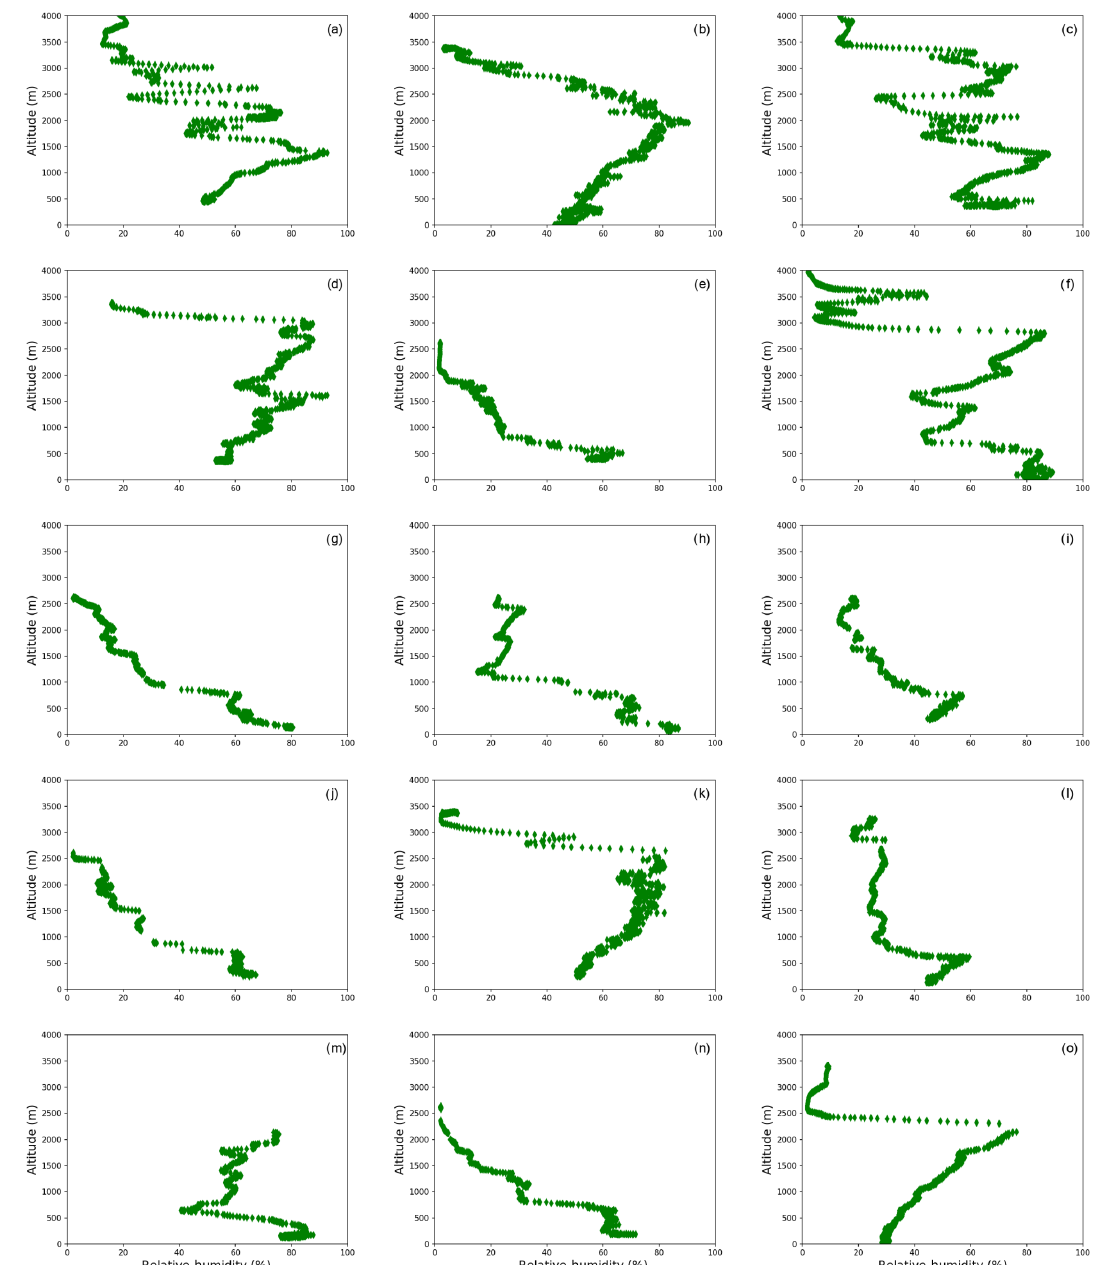
Figure 6. Vertical profiles of relative humidity at the data points defined as (a) Aldino (MD) (5 July 2011), (b) Deer_Park (TX) (13 Septem- ber 2013), (c) Edgewood (MD) (5 July 2011), (d) FairHill (MD) (29 July 2011), (e) Fresno (CA) (1 February 2013), (f) Galveston (TX) (13 September 2013), (g) Hanford (CA) (1 February 2013), (h) Hanford (CA) (4 February 2013), (i) Huron (CA) (31 January 2013), (j) Huron (CA) (1 February 2013), (k) ManvelCroix (TX) (13 September 2013), (l) Porterville (CA) (31 January 2013), (m) Smith_Point (TX) (13 September 2013), (n) Tranquility (CA) (1 February 2013) and (o) West_Houston (TX) (25 September